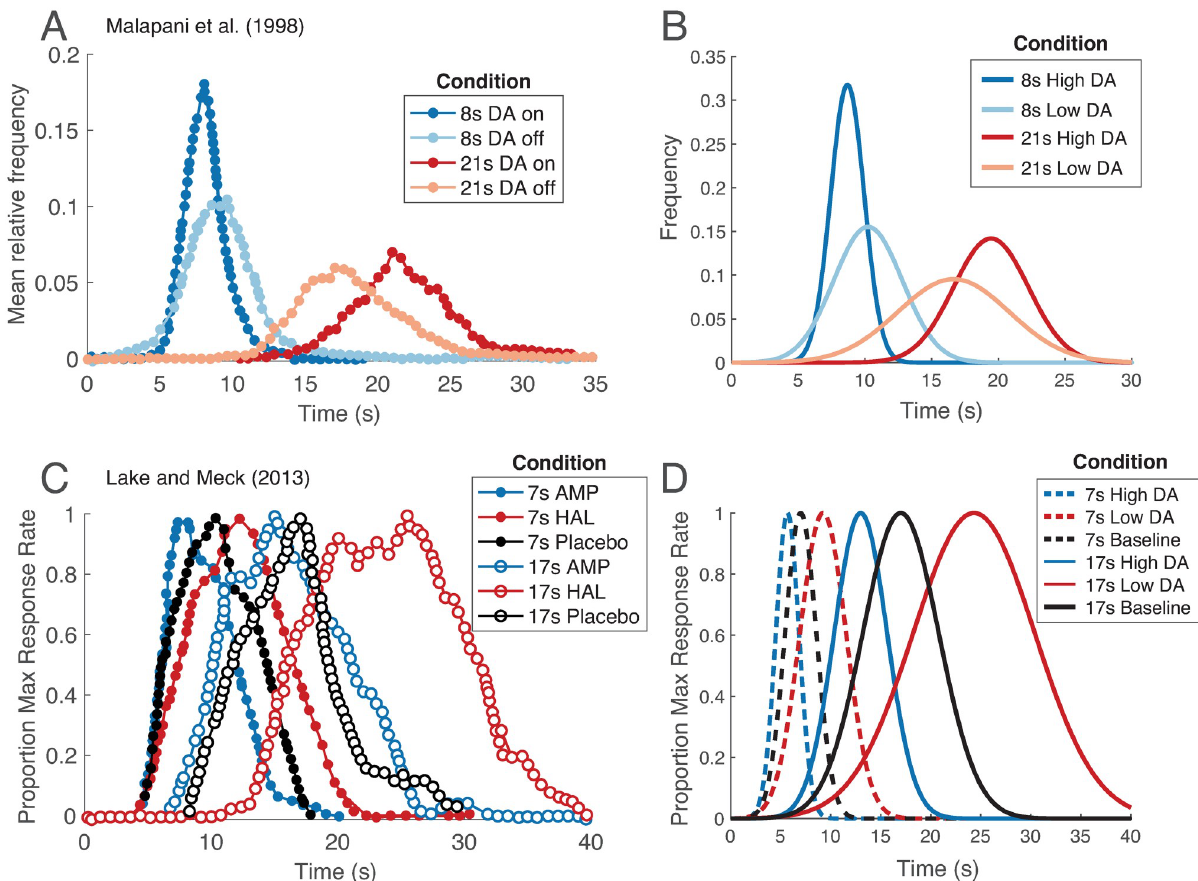
Fig 5. Rational inattention and interval timing. (A) DA masks the central tendency effect. Malapani et al. [39] have shown that when unmedicated Parkinson’s patients learn intervals of different durations in an interleaved manner, they overproduce the shorter intervals and underproduce the longer ones (light blue and orange curves). Medication rescues veridical timing (dark blue and red curves). Figure adapted from [39]. (B) Our model recapitulates this effect: When DA is high, likelihood precision is high, and the posterior closely resembles the likelihood. When DA is low, likelihood precision is low, and the posterior migrates toward the prior. (C) DA increases the speed of the internal clock. Lake and Meck [17] trained healthy human subjects on reproducing a 7- or 17-second interval. They then acutely administered either amphetamine (DA agonist) or haloperidol (DA antagonist), and observed temporal reproduction that was consistent with either a faster or a slower clock, respectively. Note that the central tendency is not captured in this experiment because each of the 7-second and 17-second intervals was presented separately in a blocked manner, but plotted in the same figure for convenience. Figure adapted from [17]. (D) Our model recapitulates this effect: When DA is high, temporal receptive fields must compress against objective time to increase likelihood precision. This results in a faster internal clock. When DA is low, temporal receptive fields expand to decrease likelihood precision. This results in a slower internal clock. For (B, D), see Methods for simulation details.